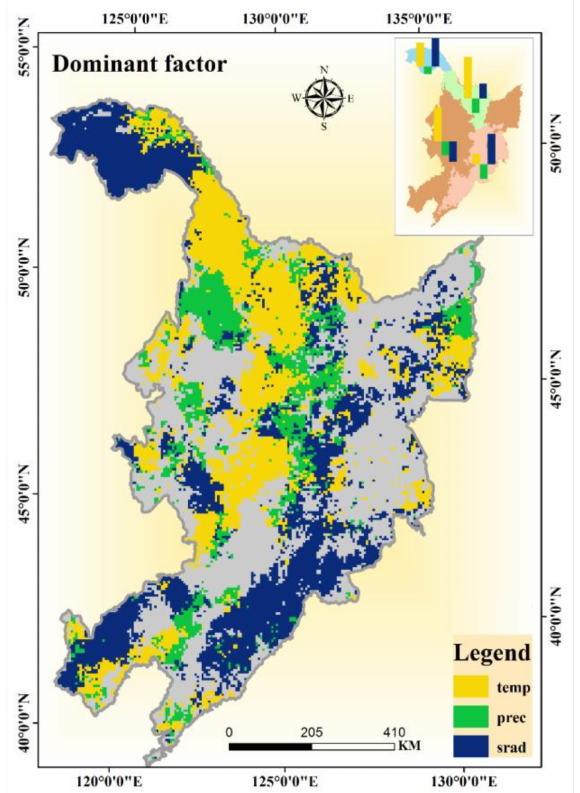
Figure 5. Dominant factors for GPP GS during 1982–2015 at pixel scale (main map) and at regional scale (the inset